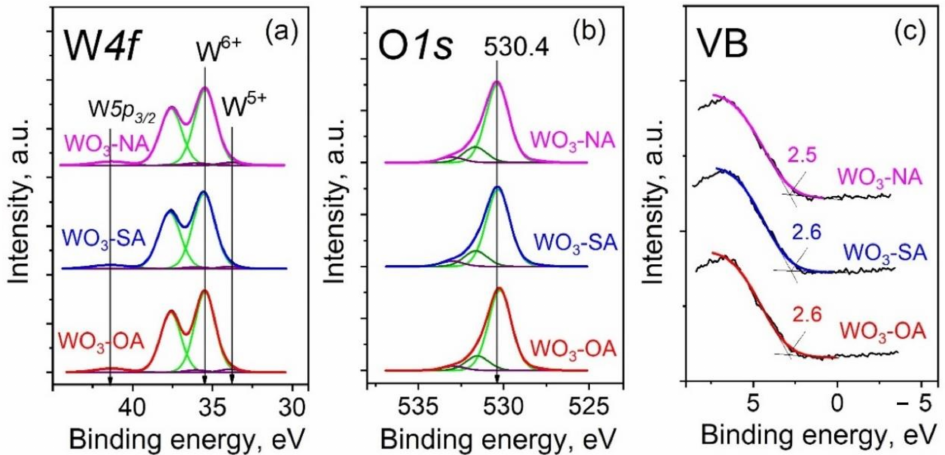
Figure 3. Deconvoluted high-resolution XPS spectra of W4f core level ( a ) and O1s core levels ( b ). XPS valence band edge plot of WO 3 prepared in different electrolytes ( c